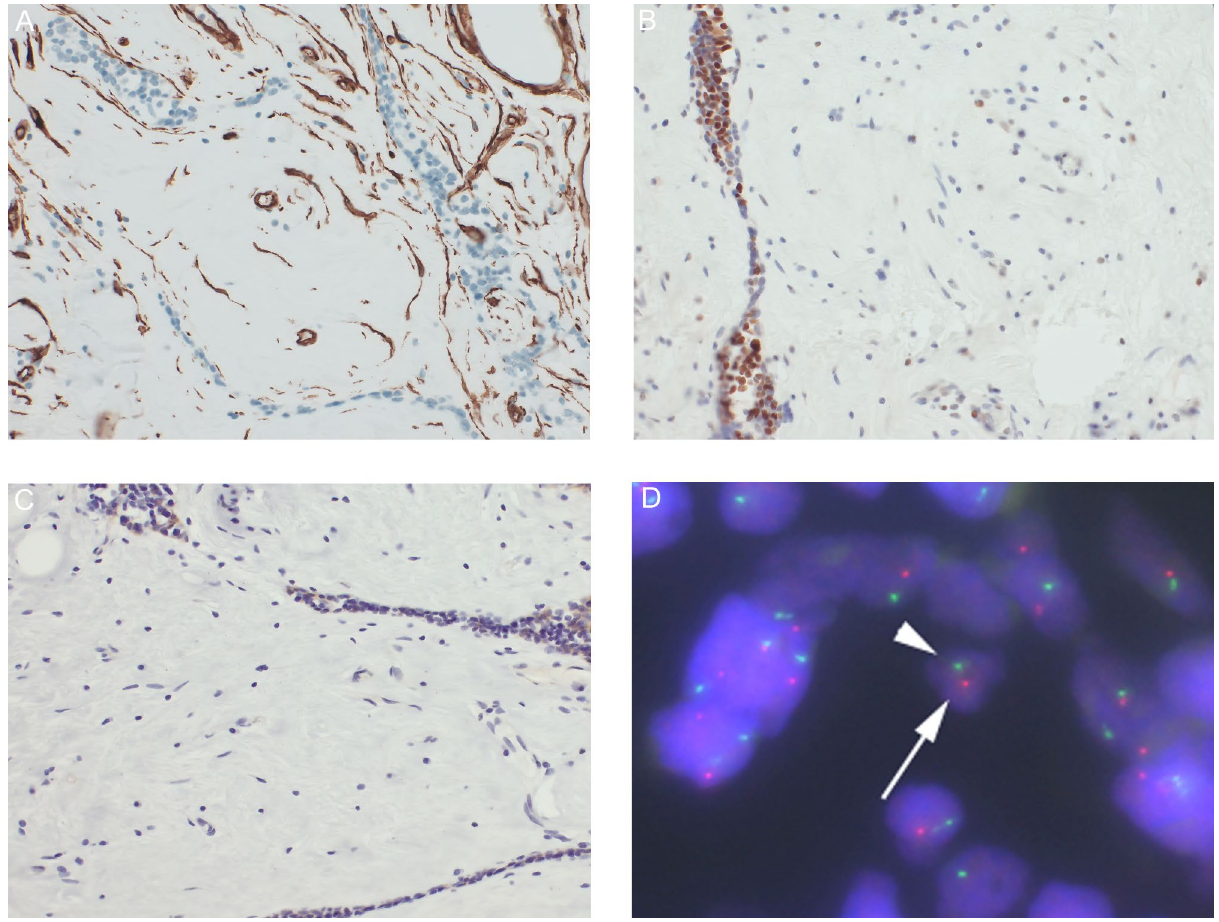
Fig. 3 Immunohistochemical images: Spindle cells stained positive for CD34 (A) and negative for RB1 (B) and FOXOA1 (C) Fluorescence in situ hybridization assay: (D) Monoallelic loss of the 13q14 region was found. (White arrow: D13S319 probe red signal, white arrowhead: 13q34 probe green